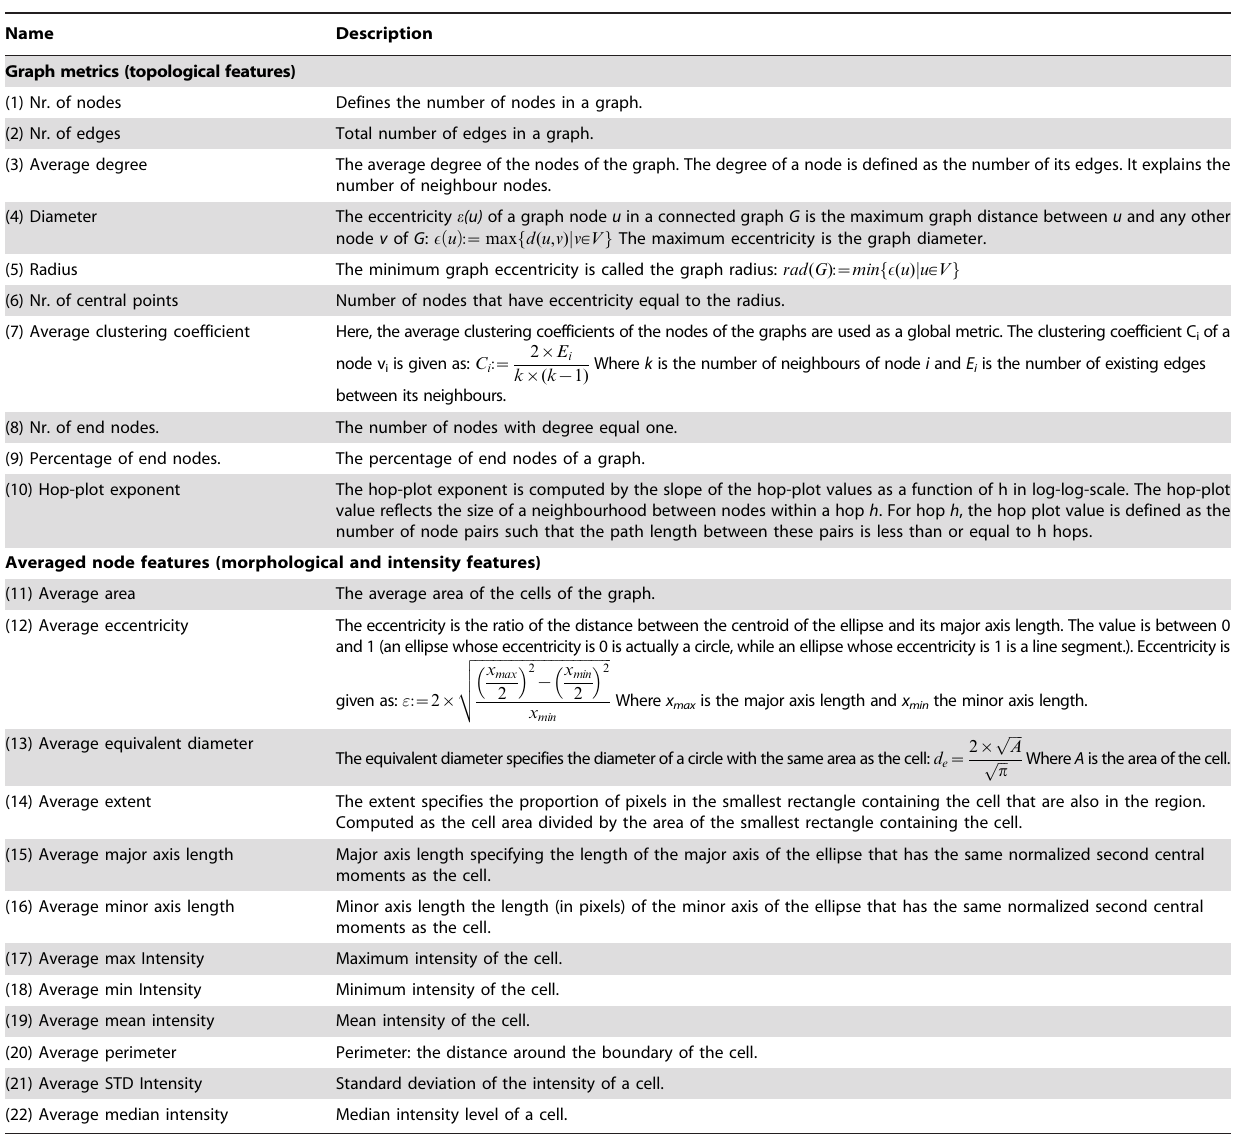
Table 1. Graph metrics used to train the classifier and their